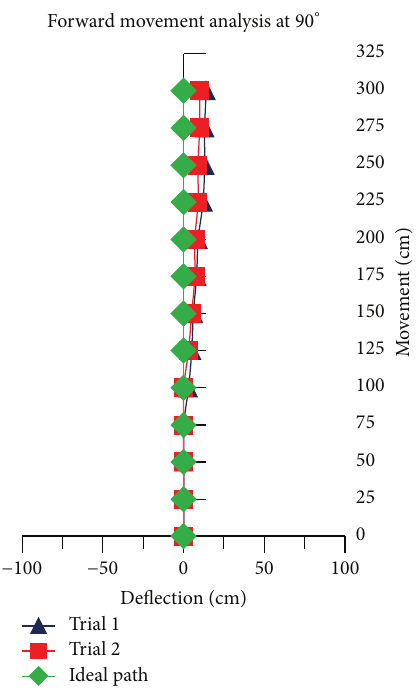
Figure 14: Forward movement versus deflections at 𝜃 = 90 ∘ .